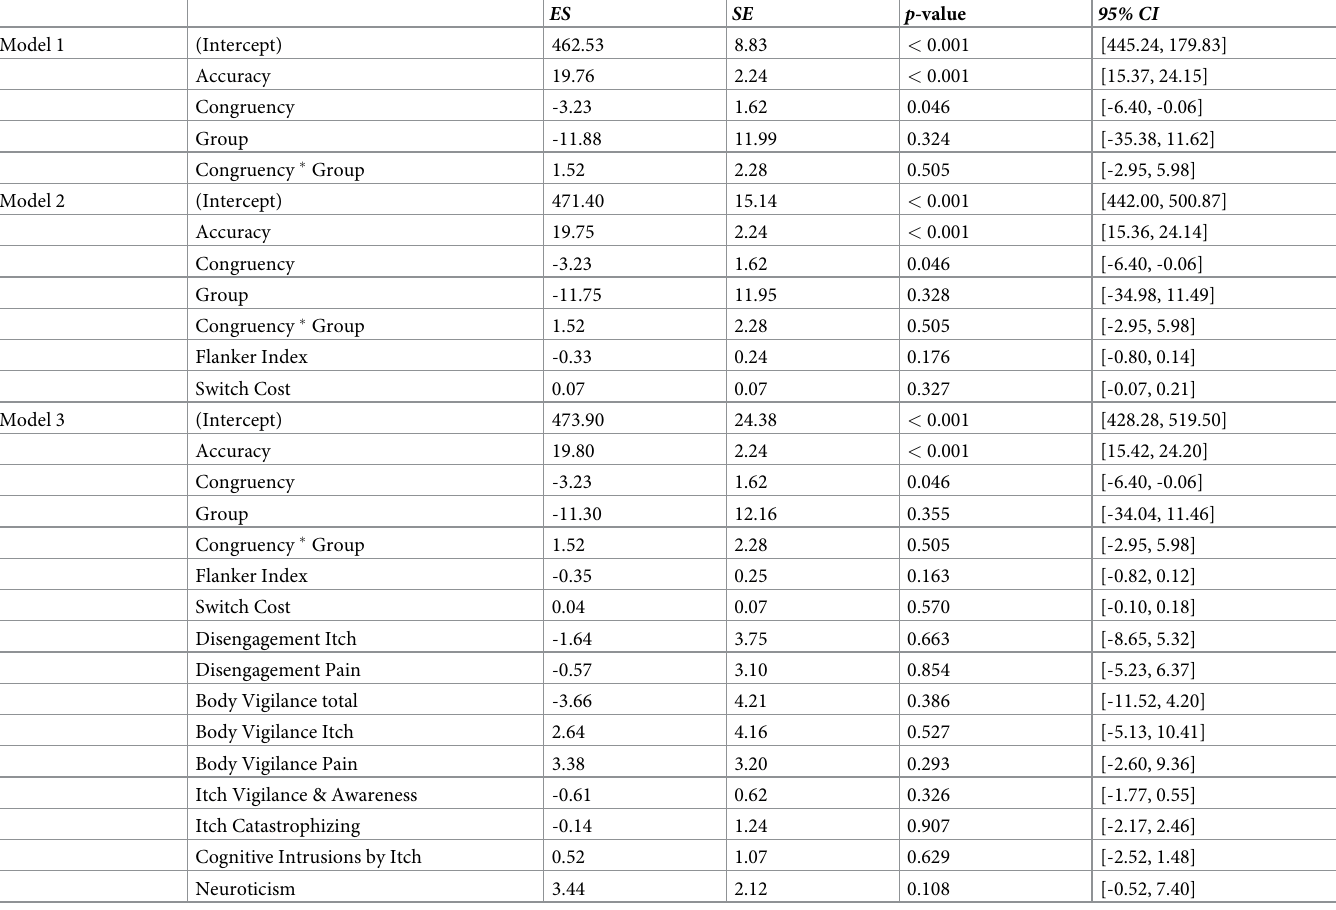
Table 3. Multilevel analyses with RT as outcome variable for the subliminal dot-probe task for itch: estimates ( ES ) with standard errors ( SE ), significance level ( p- value ) and 95% confidence intervals (95% CI ) ( n =